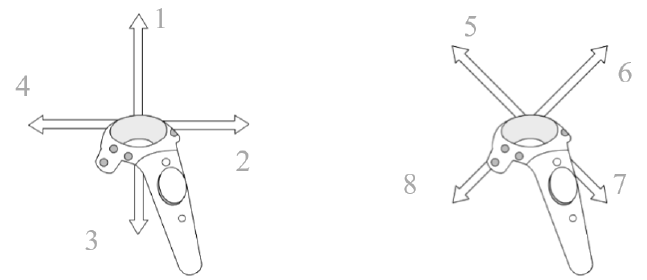
Figure 1. Eight signs of the symbol direction for recognition.